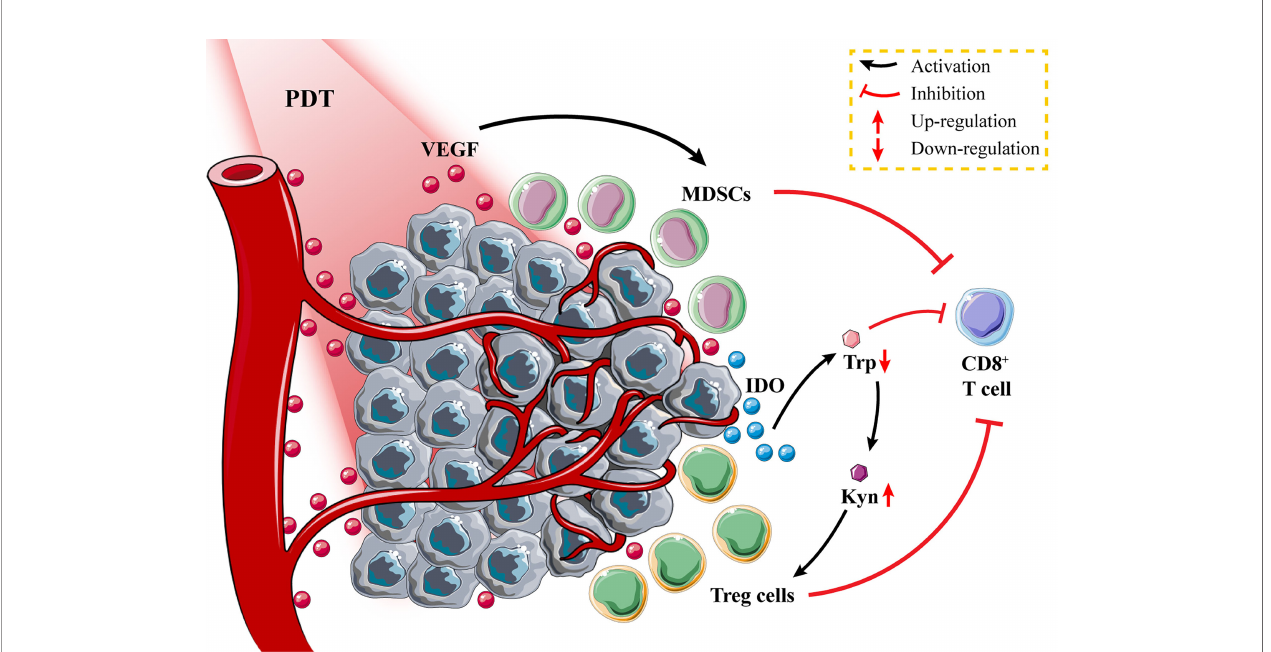
FIGURE 4 | Tumor immunosuppressive environment after photodynamic therapy (PDT). Tumor tissues secrete vascular endothelial growth factor (VEGF) to promote the proliferation of myeloid-derived suppressor cells (MDSCs); the high expression of indoleamine 2,3-dioxygenase (IDO) in tumor cells promotes the recruitment of Treg cells and inhibits the activation of CD8 + T cells through tryptophan